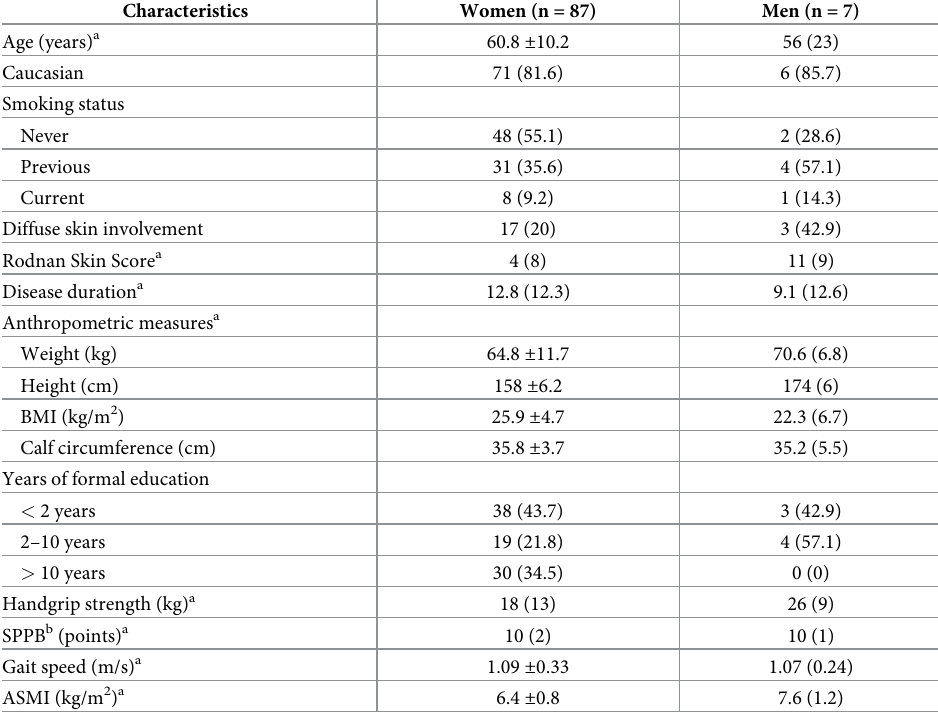
Table 1. Clinical characteristics of patients with SSc, stratified by sex. Characteristics Women (n =